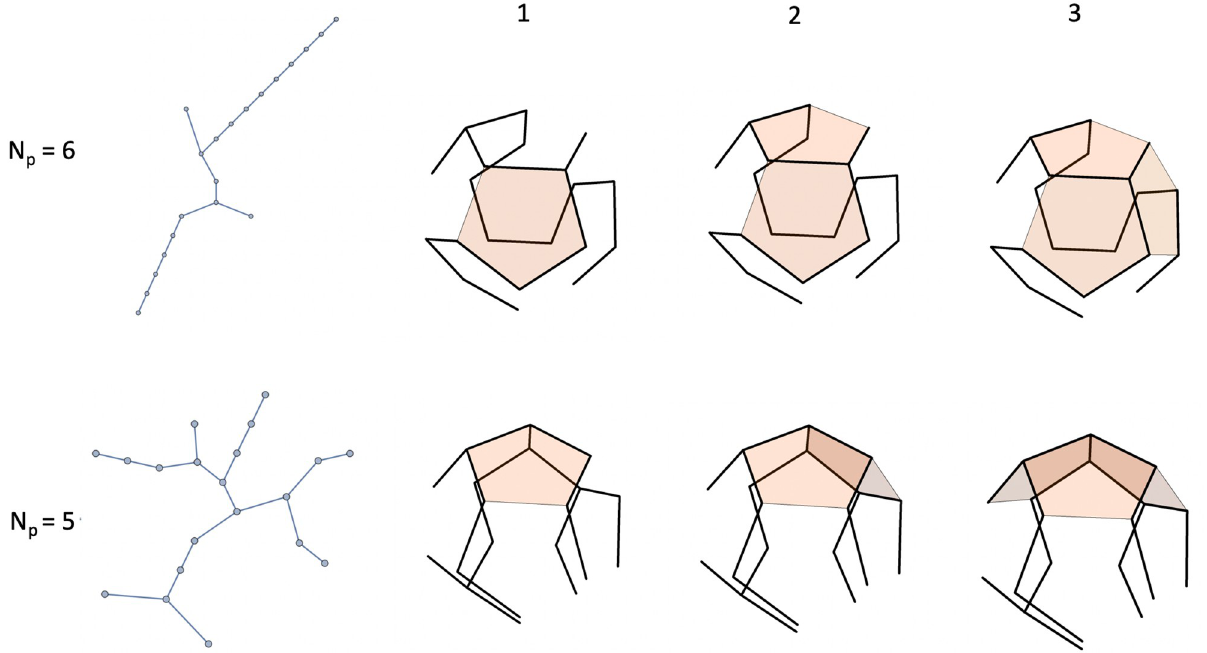
Fig 3. The first three steps of the minimum energy assembly pathways of two molecules, with wrapping numbers N p = 6 (top) and N p = 5 (bottom) respectively, for the case that the affinity of pentamer edges for each other exceeds the specific affinity for the spanning tree. The more compact N p = 5 tree allows three pentamers on sites with four links with each pentamer making two edge-to-edge contacts. For the less compact N p = 6 tree, the third pentamer only makes three contacts with a link.